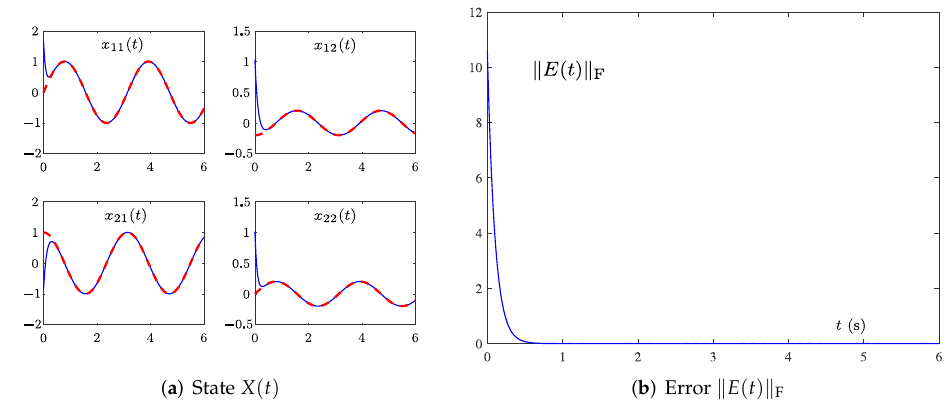
Figure 2. Simulation results by the OAZNN model (11) with λ = 10 for TVMIP of (40) under the same single-harmonic noise when f = 0.01 Hz.